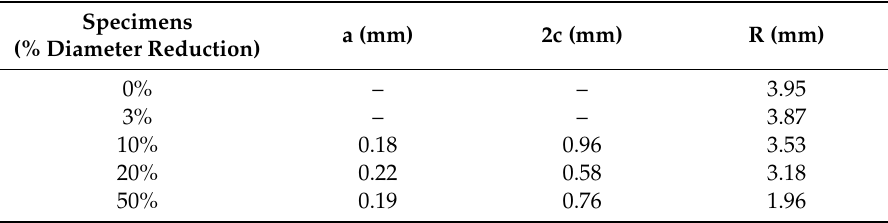
Figure 3. 3D scan images of specimens after using the galvanostatic method: ( a ) 3% reduction, ( b ) 10% reduction, ( c ) 20% reduction, and ( d ) 50% reduction ratios. Table 5. Crack depth (a), crack width (2c), diameter (R), and measured diameter reduction ratio of each specimen.